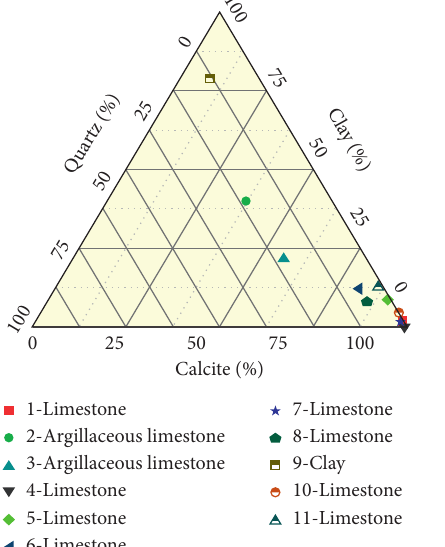
Point 7 (perpendicular to the stratification plane) Point 7 (parallel to the stratification plane) Mean value of point 7 (perpendicular to the stratification plane) Mean value of point 7 (parallel to the stratification plane) Point 8 (perpendicular to the stratification plane) Point 8 (parallel to the stratification plane) Mean value of point 8 (perpendicular to the stratification plane) Mean value of point 8 (parallel to the stratification Figure 11: Uniaxial compressive strength of rock samples of the fracture